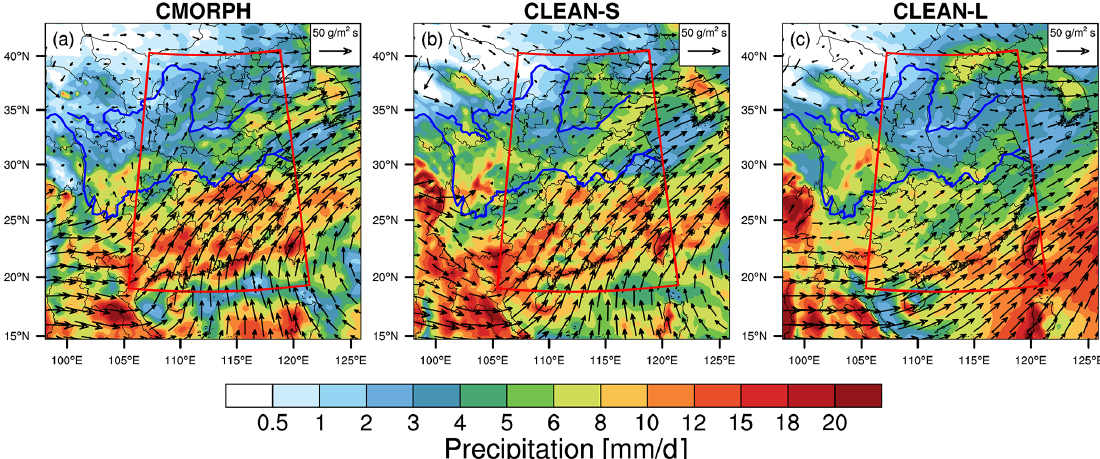
Figure 2. Mean precipitation rate (mm/day) and 700hPa moisture transport (g/m 2 s) over the small domain for the two months of June and July 2017 from (a) CMORPH and ERA5 reanalysis, (b) CLEAN-S simulation, and (c) CLEAN-L simulation. The red box (20–42 ◦ N, 105–122 ◦ E) represents the focus area of analysis in follow. (a) Precipitation data come from CMORPH, and the 700hPa moisture transport field data are obtained by processing ERA5 reanalysis.